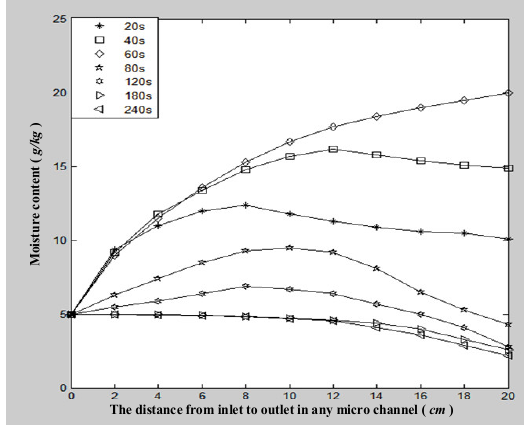
Figure 7. Change in air moisture content at various points along the passage.